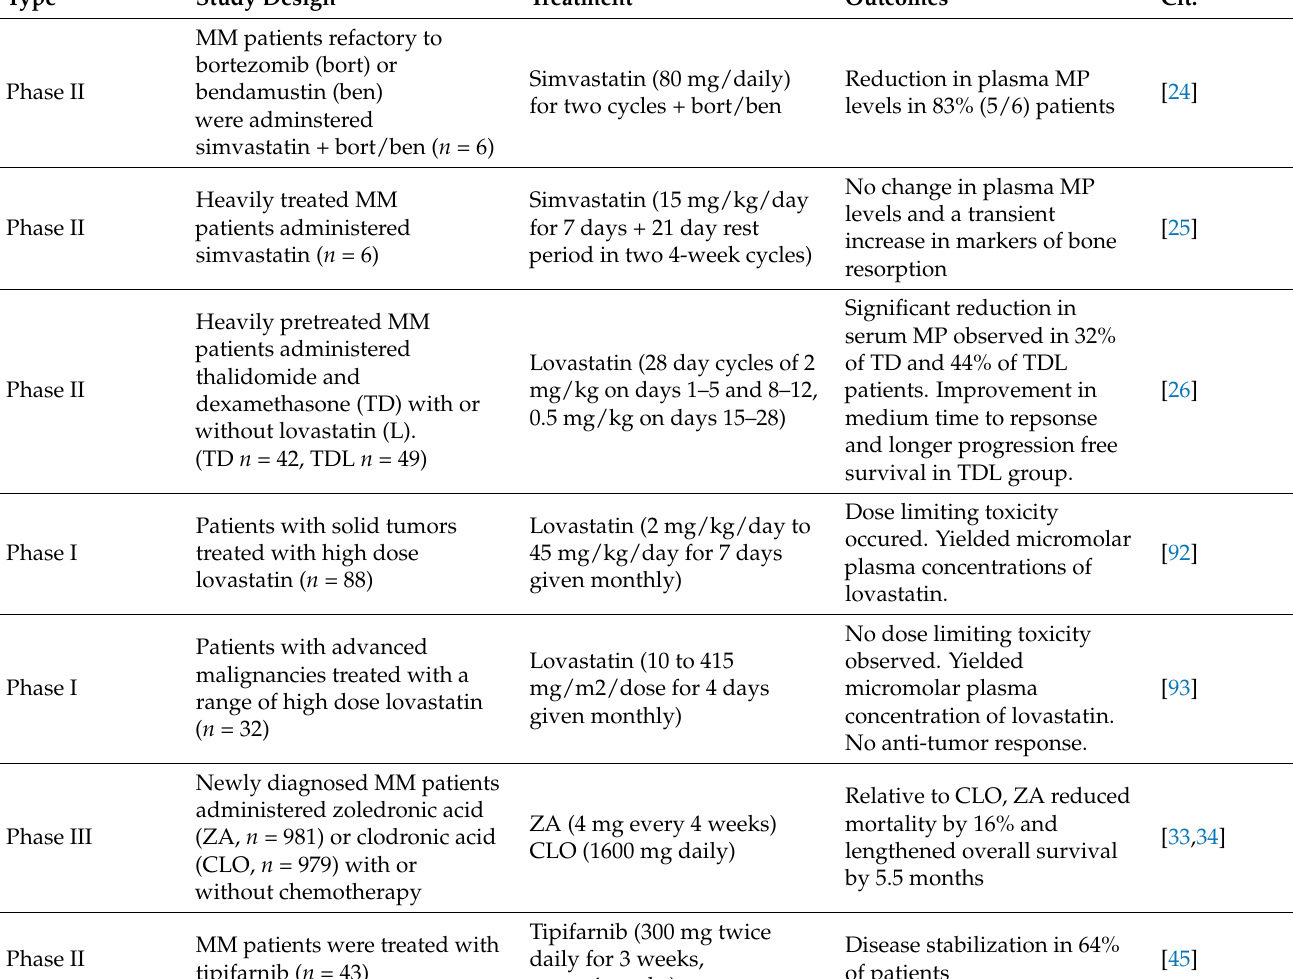
Table 2. Summary of clinical trials for IBP